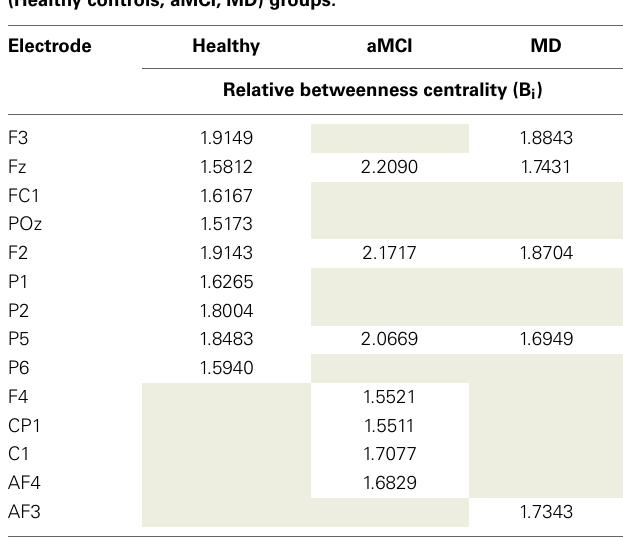
Table 2 | Description of the functional hubs identified in the three (Healthy controls, aMCI, MD)